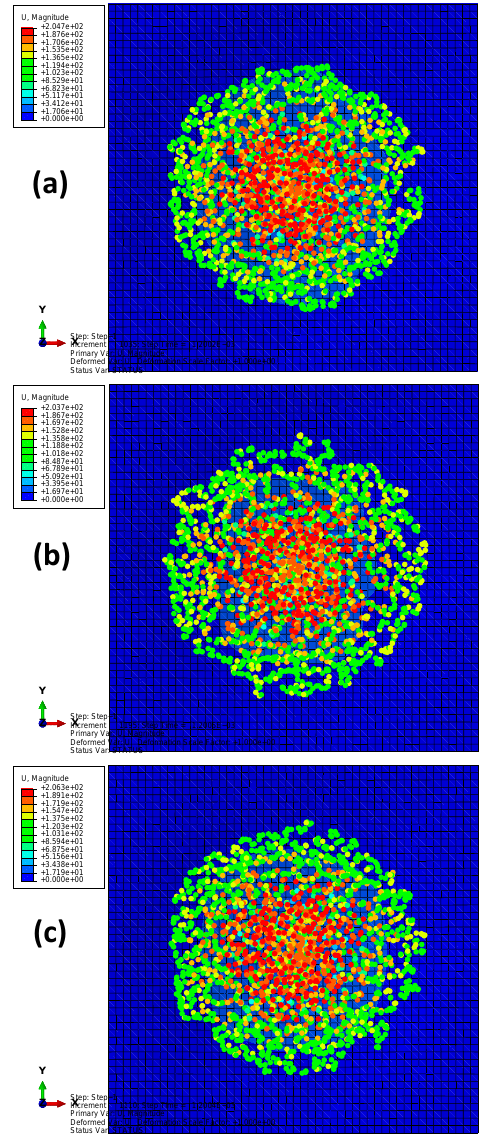
Figure 6. Projectile deformations at 1.2 ms in the models with di ff erent plate’s materials: ( a ) material 1; ( b ) material 2; ( c ) material